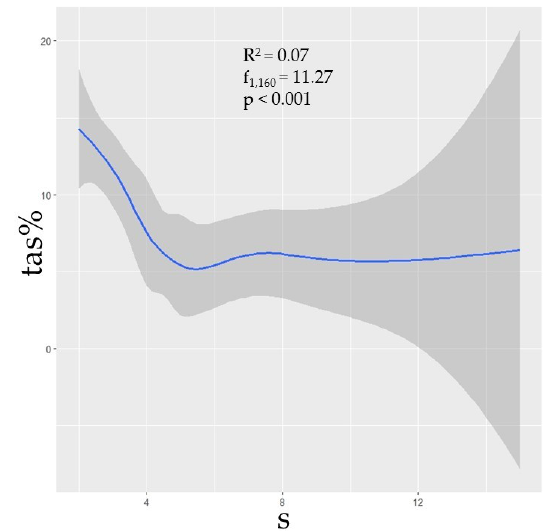
Figure 3. The curveplots show the relationship of total assemblage seroprevalence (TAS) against raw species richness (s). Confidence intervals (95%) shown in grey. Data are shown at the global scale .